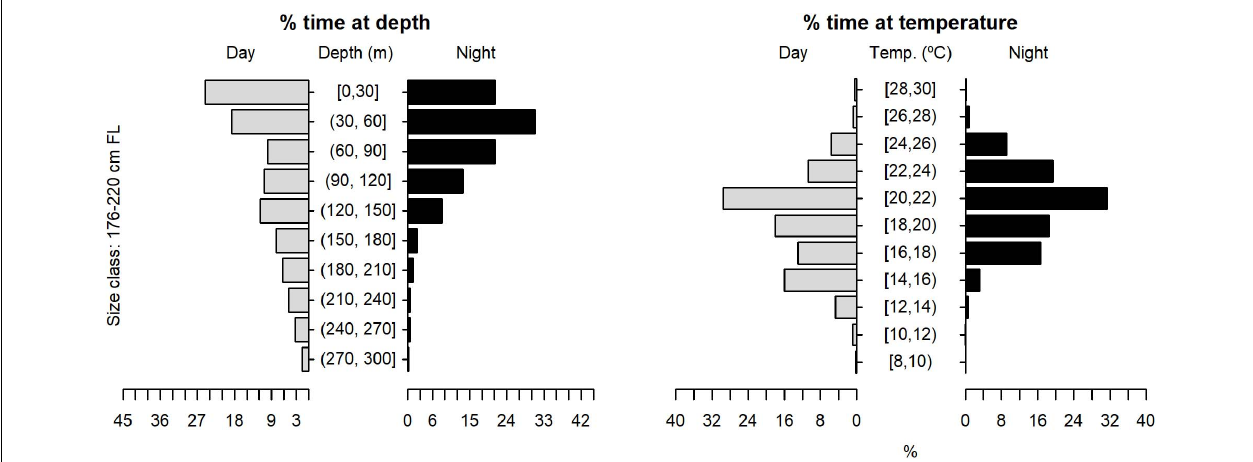
FIGURE 10 | Vertical habitat use of shortfin makos ranging in size from 176 to 220 cm FL, for daytime and night-time in terms of depth and temperature. Depth classes are categorized in 30 m intervals and temperature classes in 2 ◦ C intervals.